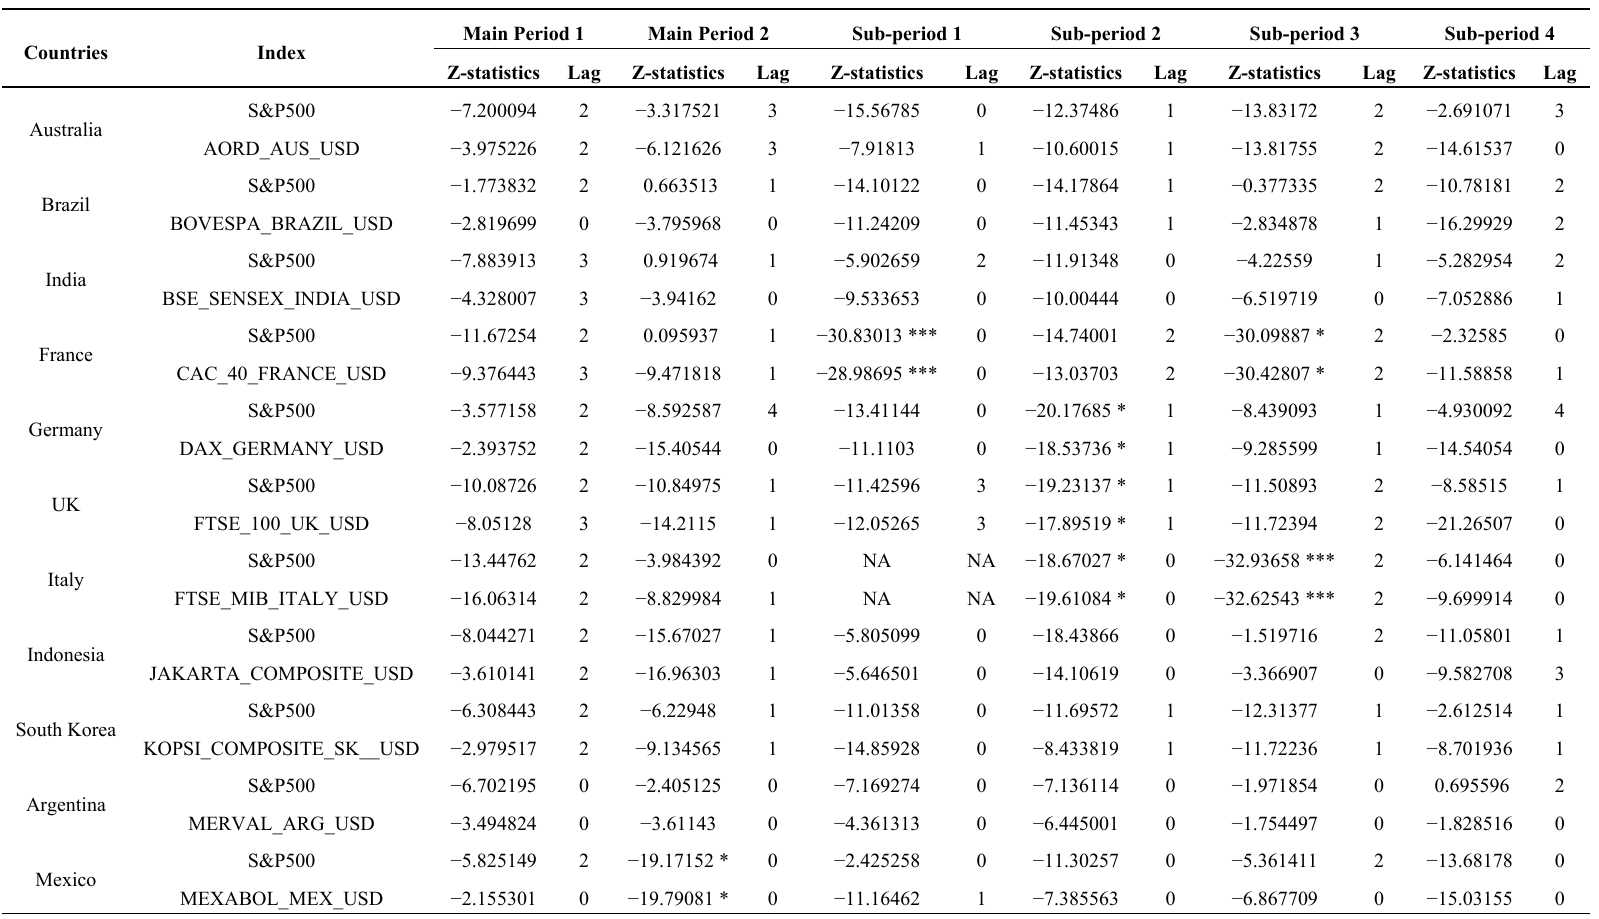
Table 3. Single Equation Cointegration